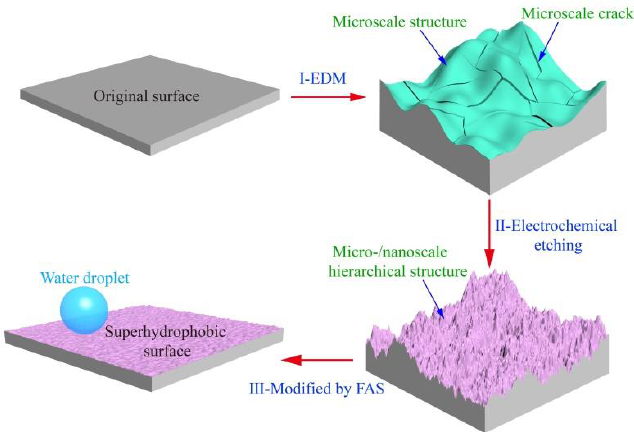
Figure 1. Schematic illustration of the superhydrophobic surface with robust micro- / nanoscale hierarchical structures fabricated on titanium. Step I: Workpiece is machined by the electrical discharge machining (EDM) process, where microscale craters and cracks are generated; Step II: Electrochemical etching (ECE) is used to manufacture nanoscale structures on the EDM machined surface. Step III: The surface with micro- / nanoscale hierarchical structures is modified by 1H,1H,2H,2H-perfluorooctadecyltrichlorosilane (FAS) and dried.